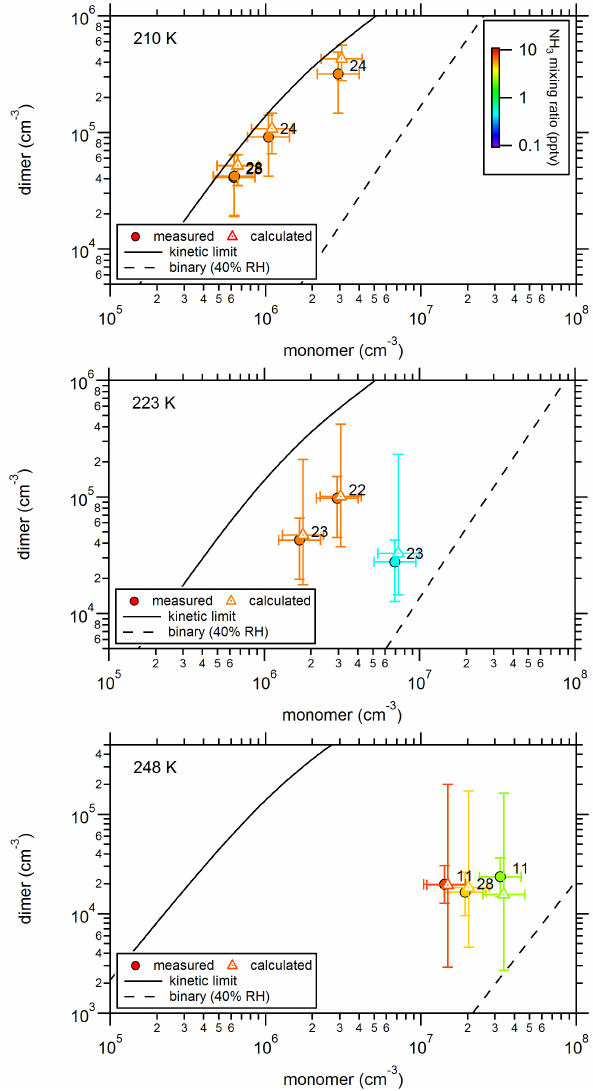
Figure 9. Sulfuric acid dimer concentrations as a function of the sulfuric acid monomer concentration at three different temperatures for the ternary system involving ammonia (ammonia mixing ratio indicated by the color code). The colored circles are the measured concentrations. Lines are from model calculations indicating the ex- pected concentrations for the binary system (dashed line) and the kinetic limit (solid line). The numbers indicate the RH (in %) dur- ing an experiment. Open colored triangles are the simulated dimer concentrations using the reaction scheme from Fig. 10. These are slightly offset to the right in order to improve